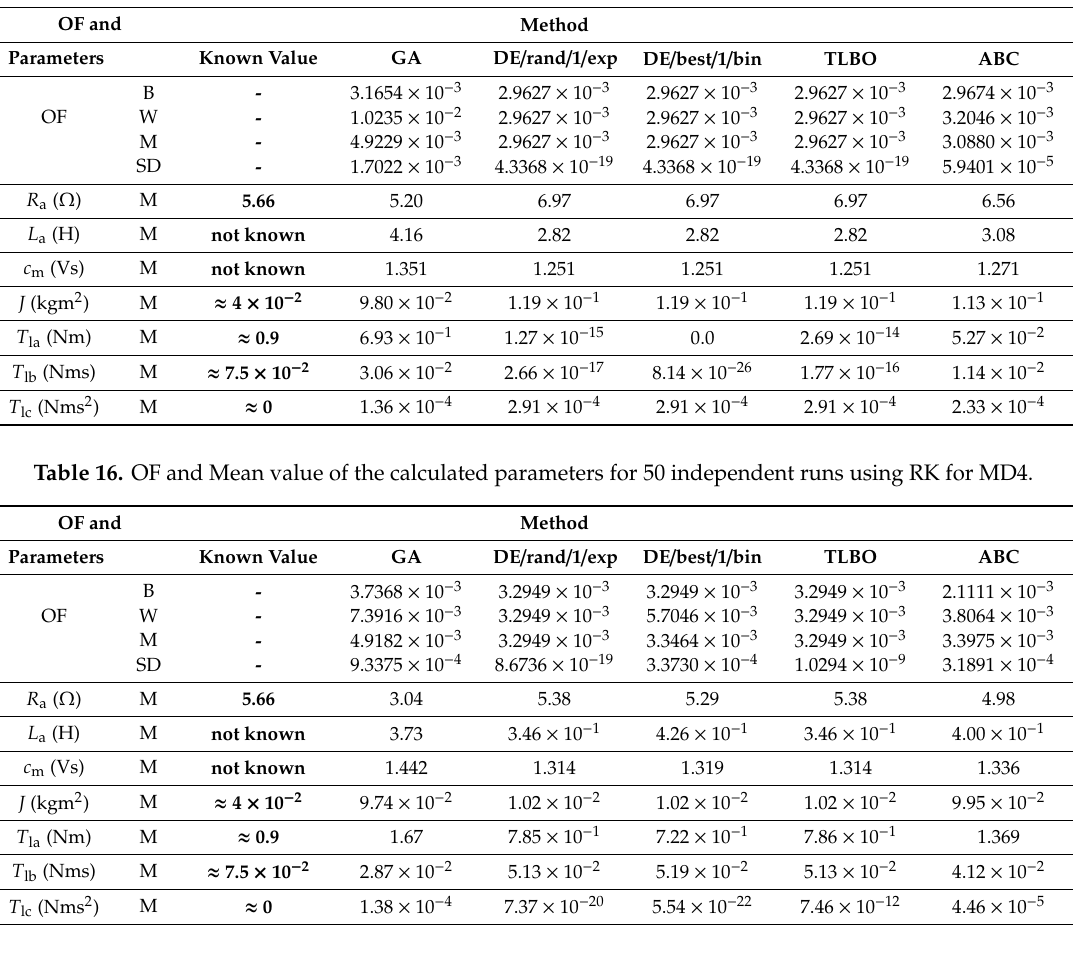
Table 15. OF and Mean value of the calculated parameters for 50 independent runs using EM for MD4. OF and Parameters